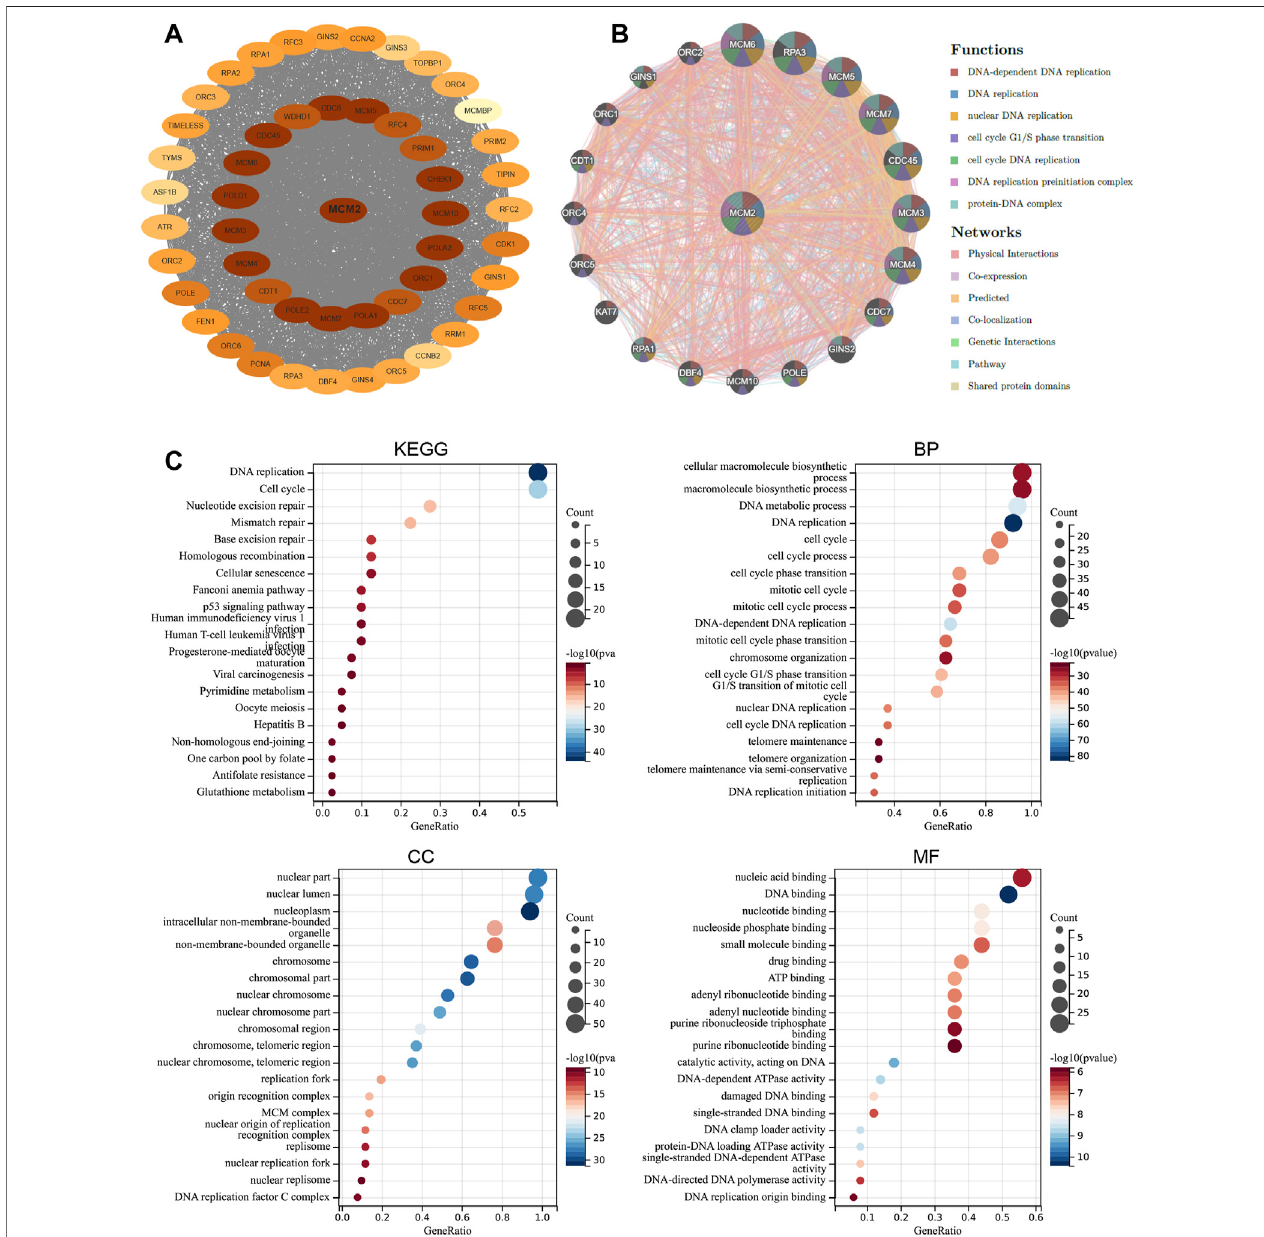
FIGURE 7 | Functional enrichment and co-expression network of MCM2 at the gene and protein levels. (A) PPI network. The related proteins of MCM2. The color depthrevealedthecorrelationbetweenMCM2andotherproteins,whichmeansthatthedarkerthecolor,theclosertherelationship. (B) GGInetwork. (C) KEGGandGO analyses of 50 targeted binding proteins of MCM2 in patients with